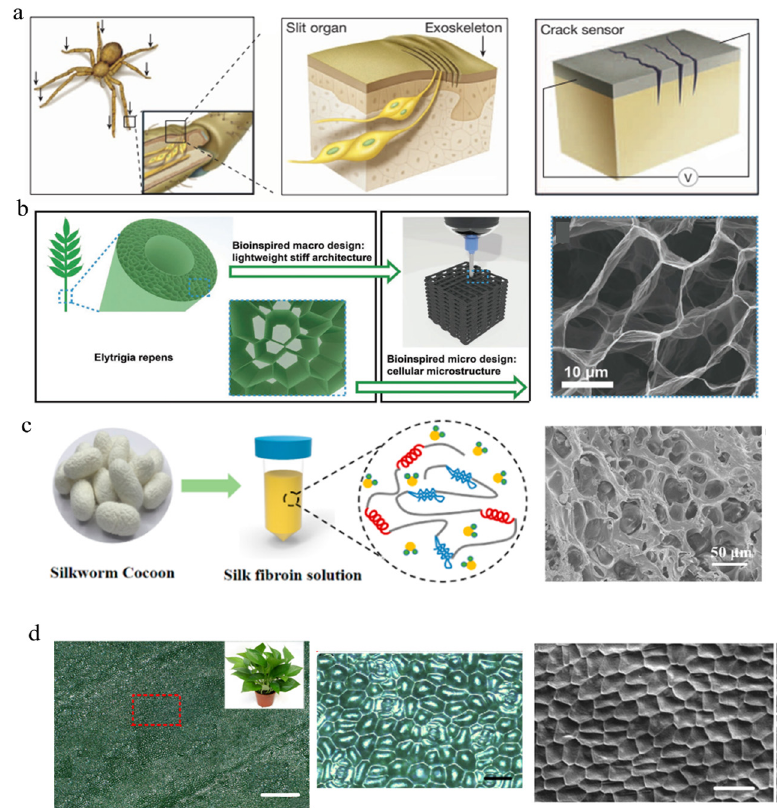
Figure 5. Schematic illustrations and images of bio-inspired pressure sensors. ( a ) Schematic of a spider’s sensory system and an ultra-mechanosensitive pressure sensor based on spider-inspired nanoscale crack junctions [31]. ( b ) Schematic of Elytrigia repens and 3D-printed hierarchical structure. SEM image of the hierarchical structure [140]. ( c ) Schematic illustration of the fabrication of the silk fibroin-based hydrogel. SEM image of interconnected porous architecture (right) [141]. ( d ) Optical images of an aureum leaf and SEM image of a replicated microstructured PDMS film. Scale bar: 1000 μ m (left), 100 μ m (middle), and 100 μ m (right) [142].